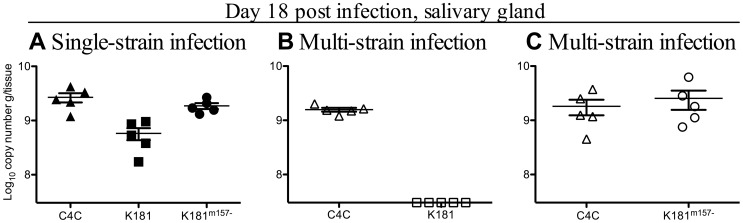
Within-host competition requires m157.A loss of function mutation was generated in the MCMV strain, K181, though the deletion of 104 bp in the m157 gene. B6 mice were inoculated i.p. with 1×104 pfu of either C4C, K181 and or K181Δm157 (closed symbols) or inoculated with total of 1×104 pfu of a mixed inoculum of equal proportions of C4C and K181 or C4C and K181Δm157 (open symbols). A Salivary gland viral DNA levels in single strain infected B6 mice 18 days p.i. B. Salivary gland viral DNA levels in C4C and K181 co-infected mice 18 days p.i. C Salivary gland viral DNA levels in C4C and K181Δm157 co-infected mice 18 days p.i. Note K181 was excluded from the salivary glands when co-infected with C4C. However, deletion of m157 restored the replication of K181 (K181Δm157) during multi-strain infection. The x-axis represents the limit of detection for the K181 qPCR (3.09×105 copy number/g of tissue), n = 5 mice/group.